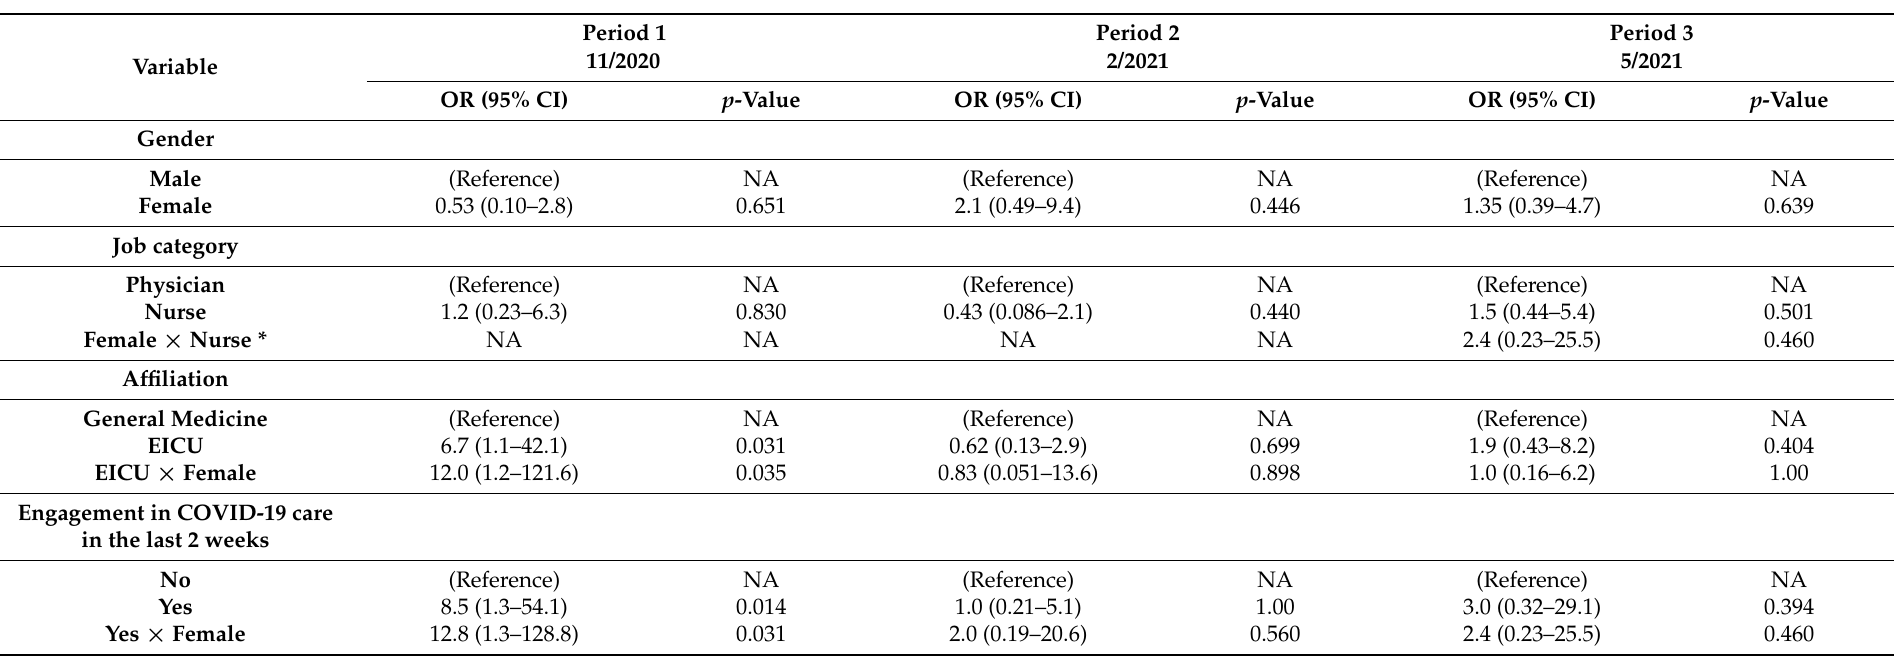
Table 3. Prevalence of burnout depending on variables based on logistic regression